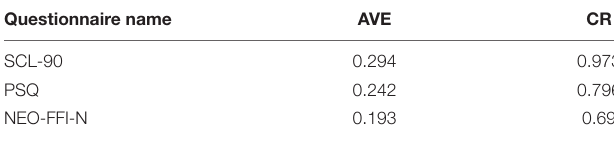
TABLE 2 | Reliability analysis of questionnaires used in this study. TABLE 4 | Convergent validity analysis of the